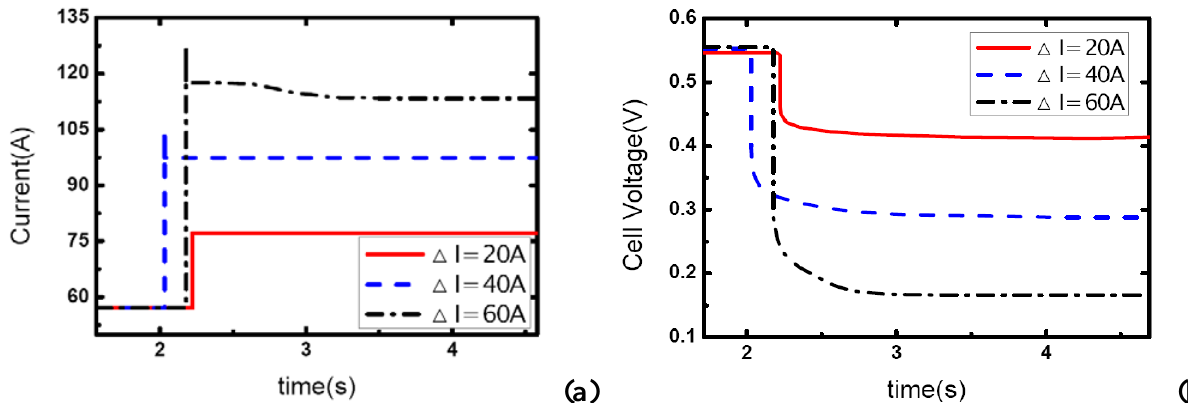
1.46, (b) corresponding dynamic voltage responses.